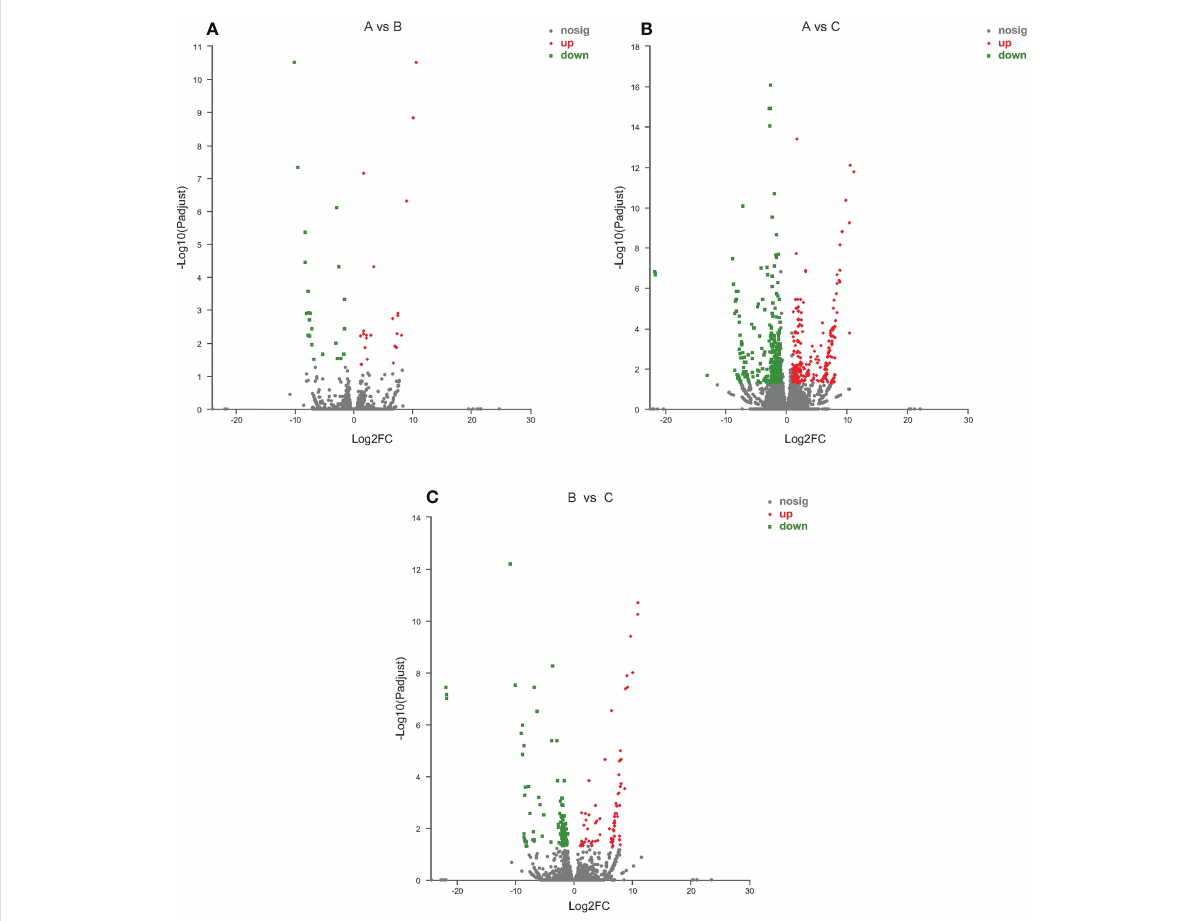
FIGURE 1 Volcano plot of differentially expressed genes identi fi ed from different temperature groups. (A) 13°C group compared with 18°C group; (B) 8°C group compared with 18°C group; (C) 8°C group compared with 13°C group. Each dot represents a gene, blue dots representing signi fi cantly down regulated genes, red dots representing signi fi cantly up regulated genes, and gray dots representing not signi fi cantly different